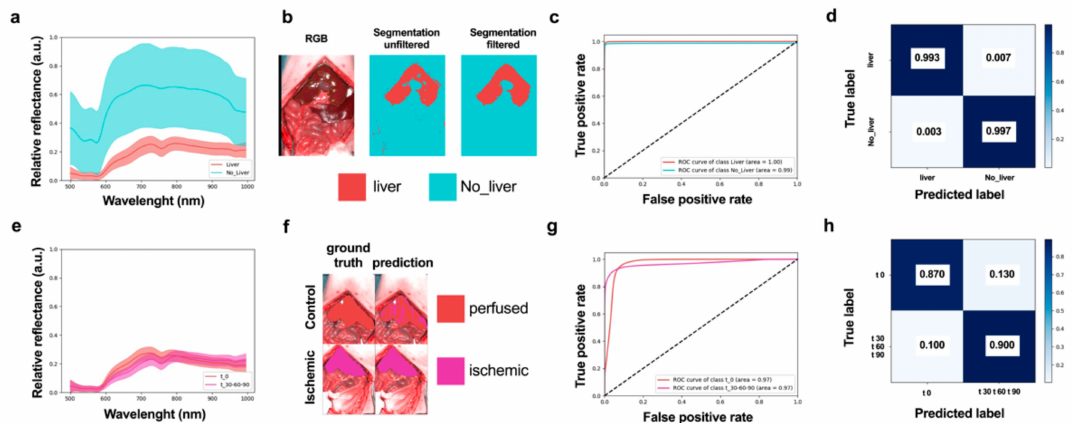
Figure 3. AI-based training and evaluation in the ischemic phase. ( a ) Liver and non-liver spectral distributions showing mean (central curve) and 1 s.d. (region). ( b ) Visualization of automatic tissue segmentation of liver and non-liver classes with and without post-segmentation filtration. ( c ) Receiver operator characteristic (ROC) curves corresponding to liver and non-liver classes, showing the trend relationship between false positive and true positive rates. ( d ) Confusion matrix showing specificity and sensitivity of tissue segmentation CNN. ( e ) Spectral distributions of perfused and ischemic classes. ( f ) Visualization of tissue automatic tissue characterization results with two classes (perfused and ischemic). ( g ) ROC curves of tissue characterization CNN showing the relationship between false positive and true positive rates. ( h ) Confusion matrix showing specificity and sensitivity of tissue characterization. ( n =